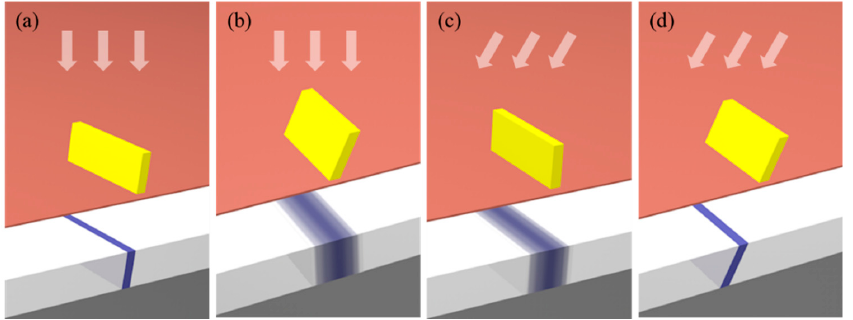
Figure 1. Schematic diagram of transient dose region suppression. White arrow indicates the incident angle of X-rays, yellow strip is the absorber and the blue line is the exposed region. When X-rays were incident to normal direction, ( a ) the vertical absorber had a narrower transient dose region than ( b ) the oblique absorber. In the oblique exposure, ( c ) the vertical absorber had a broad transient dose region, and ( d ) the oblique absorber had a narrow region.